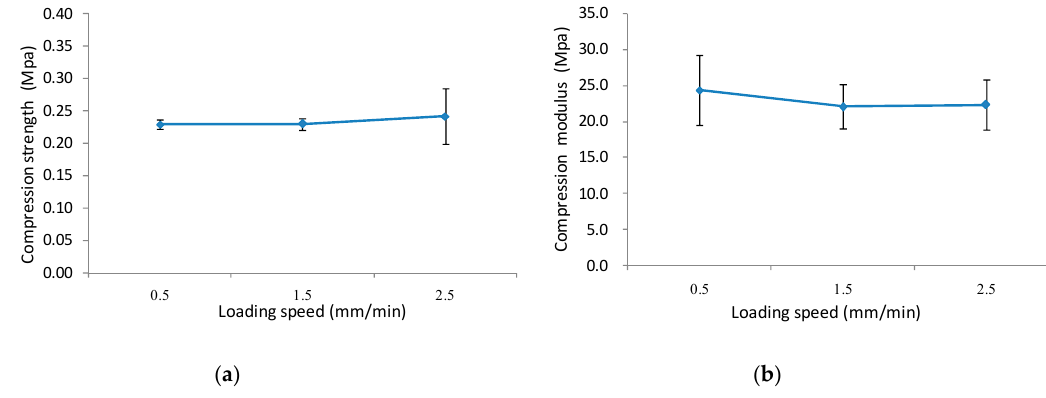
Figure 8. The e ff ect of loading speed on compression properties: ( a ) compression strength; Figure 8. The effect of loading speed on compression properties: ( a ) compression strength; ( b ) ( b ) compression modulus (surface sheet: 6.35 mm PLY; core thickness: 25.4 mm; and vertical bar: error compression modulus (surface sheet: 6.35 mm PLY;core thickness:25.4mm; and vertical bar: error bar with standard bar with standard deviation).